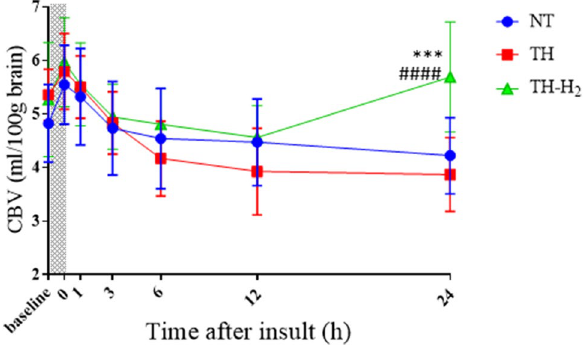
Figure 5. Cerebral blood volume (CBV, mL/100 g brain) at the end and at 1, 3, 6, 12, and 24 h after hypoxic- ischemic insult in normothermia (NT, n = 10), therapeutic hypothermia (TH, n = 8), and TH with hydrogen gas inhalation (TH + H 2 , n = 8) groups. *** p < 0.001 vs. the NT group; #### p < 0.0001 vs. the TH